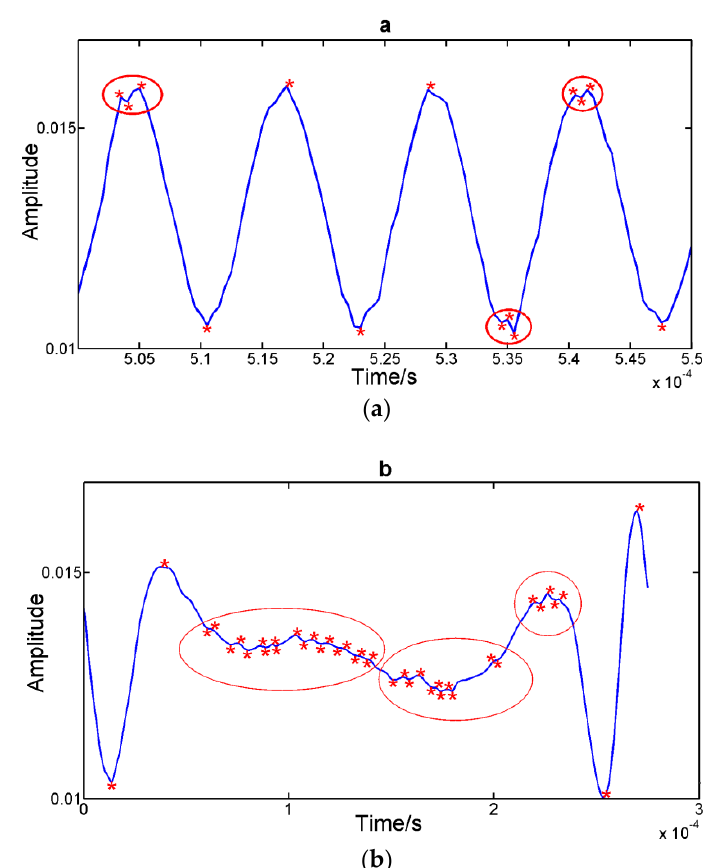
Figure 2. ( a ) Extreme points in the experiment when there are noises in the auxiliary interferometer. ( b ) Extreme points in the experiment when there is the mode-hopping signal in the auxiliary interferometer.